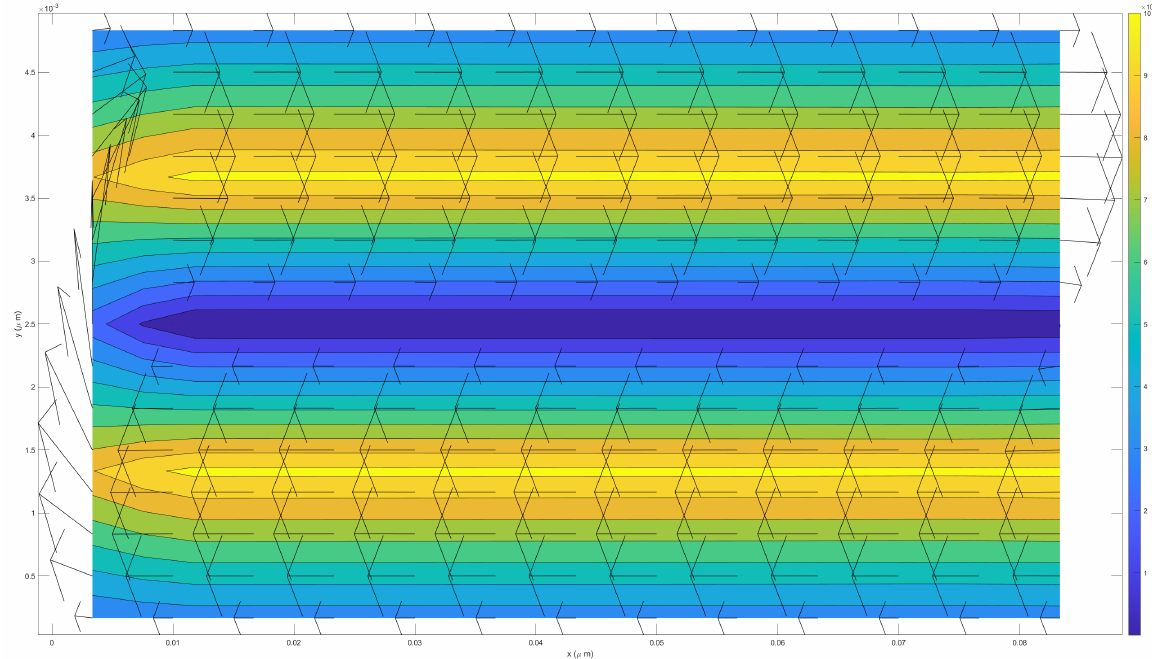
Figure 22. Velocity vectors and magnitude in PCM field. The power distribution inside BAW slab for first and second mode are plotted in Figure 23. The distribution is axially and matches the analytic solution given in Appendix